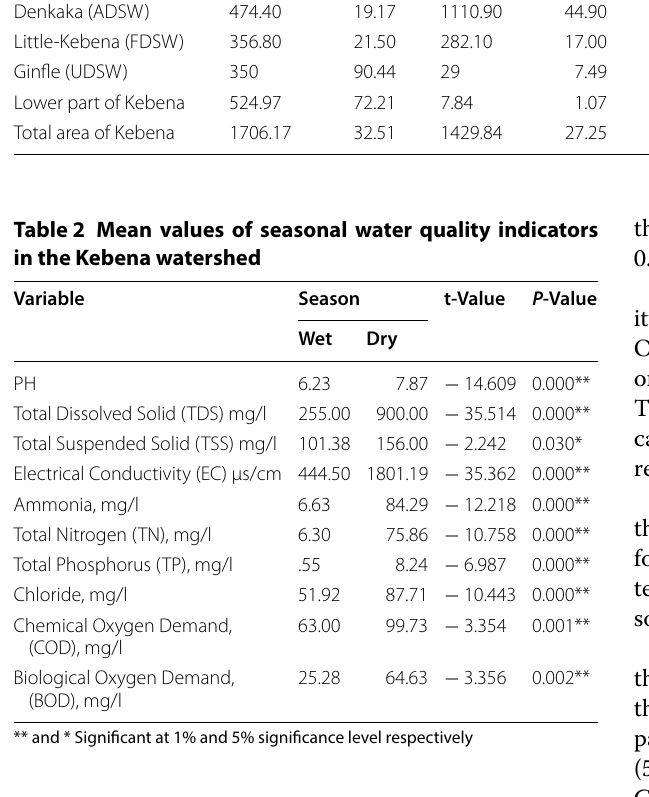
** and * Significant at 1% and 5% significance level respectively